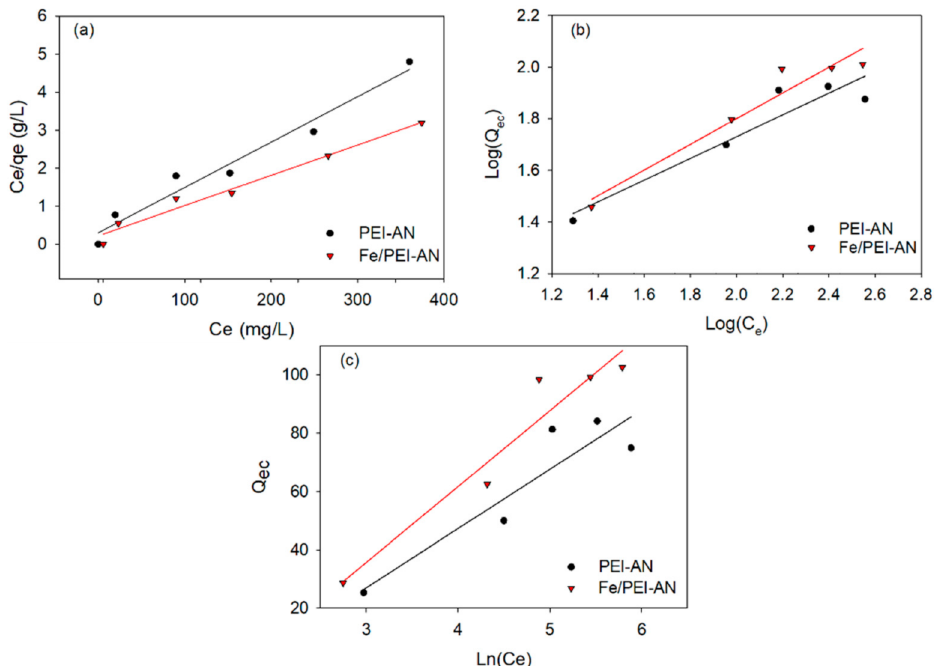
Figure 6. Plotted isotherm models: ( a ) Langmuir, ( b ) Freundlich, and ( c ) Temkin. Table 4. Calculated parameters of isotherm models. Isotherm Models Parameters PEI-AN Fe/PEI-AN